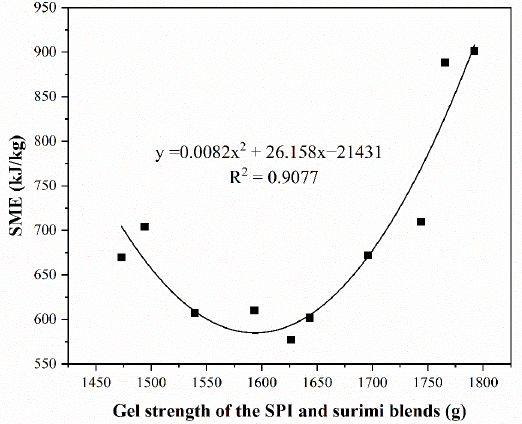
Figure 5. Relationship between the gel strength of the SPI and surimi blends and the